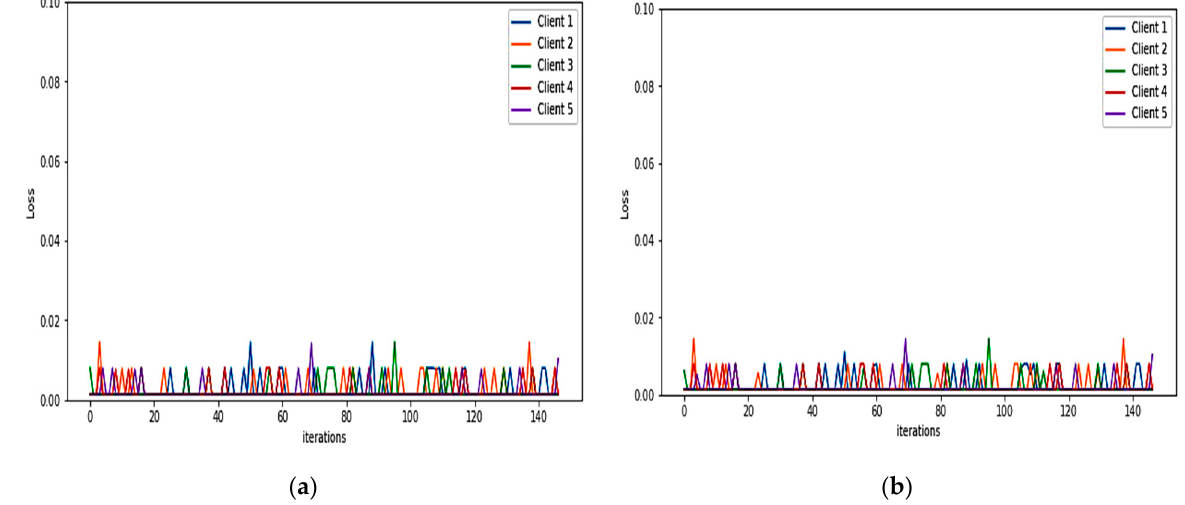
Figure 8. Losses in testing for each client of the proposed algorithm using: ( a ) BoT-IoT (full features); ( b ) BoT-IoT (best features).